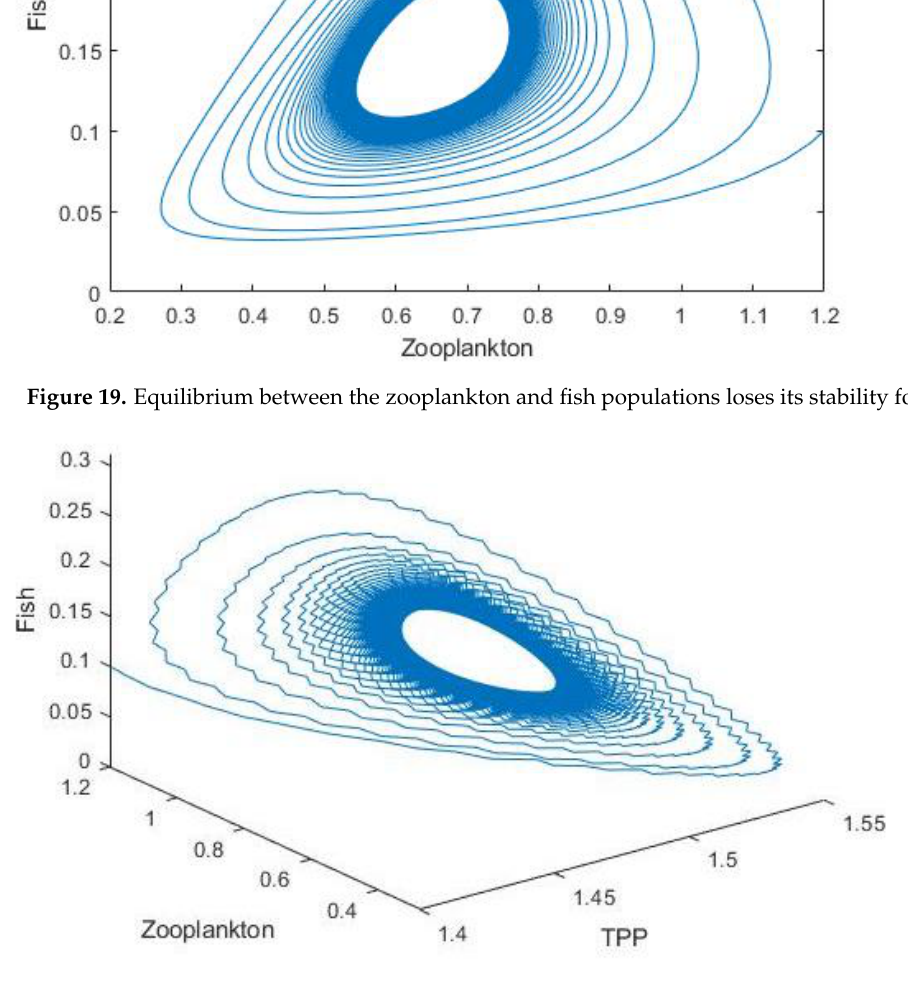
Figure 20. Equilibrium of all populations loses its stability for τ = τ +